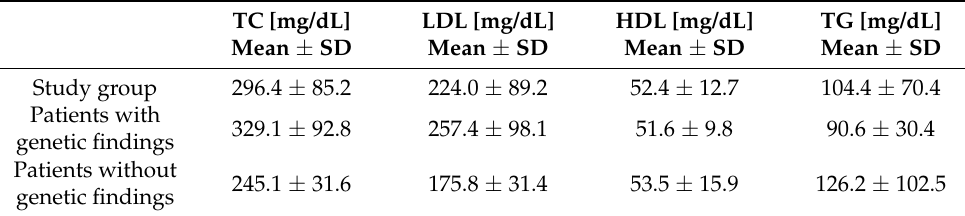
Table 2. Mean concentration of each lipid fraction in the following groups of patients.